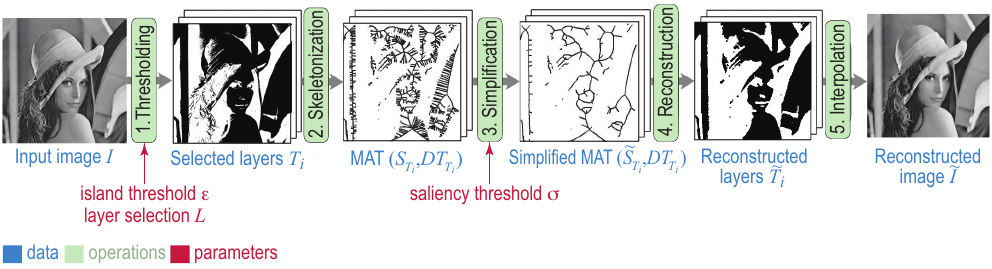
Figure 1. Dense medial descriptor (DMD) computation